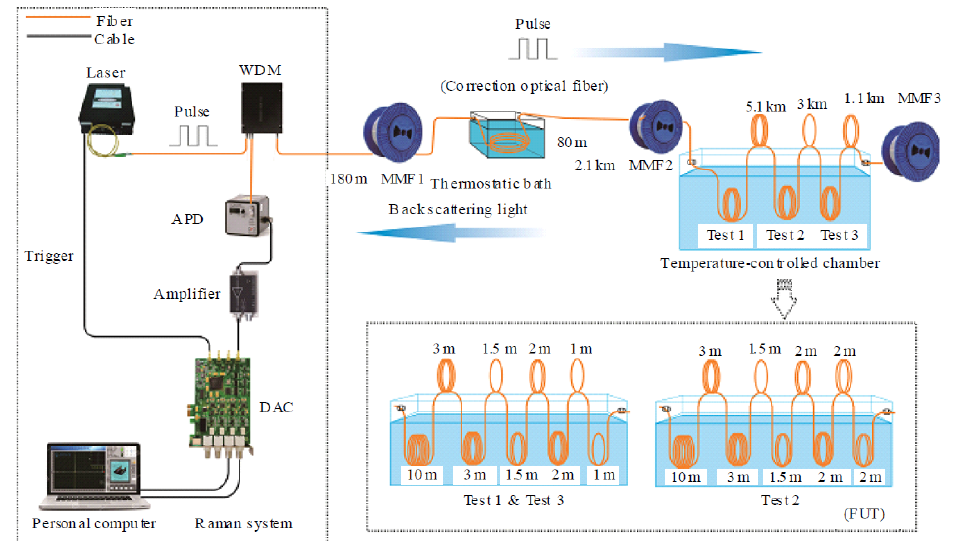
Fig. 2 Experimental setup of RDTS based on self-demodulation method.